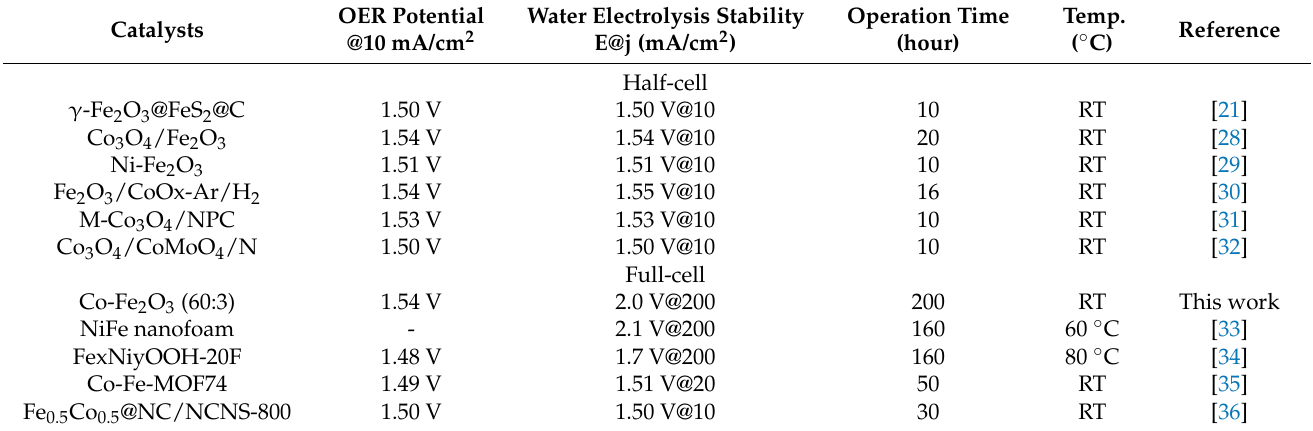
Figure 7. The stability test of the full-water electrolysis. ( a ) At 2.0 V for 200 h and ( b ) the LSV curves before and after the stability test. Table 2. Catalytic properties of transition metal oxide electrocatalysts in alkaline media (1.0 M KOH).